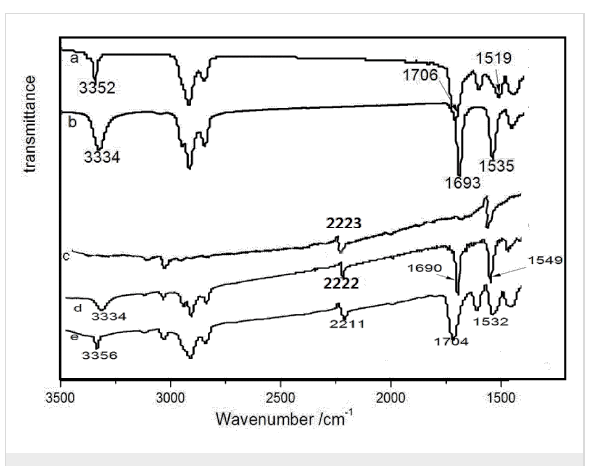
Figure 4: IR spectra of (a) T 1 , (b) T 2 , (c) TCNQ, (d) T 2 /TCNQ, and (e) T 1 /TCNQ.